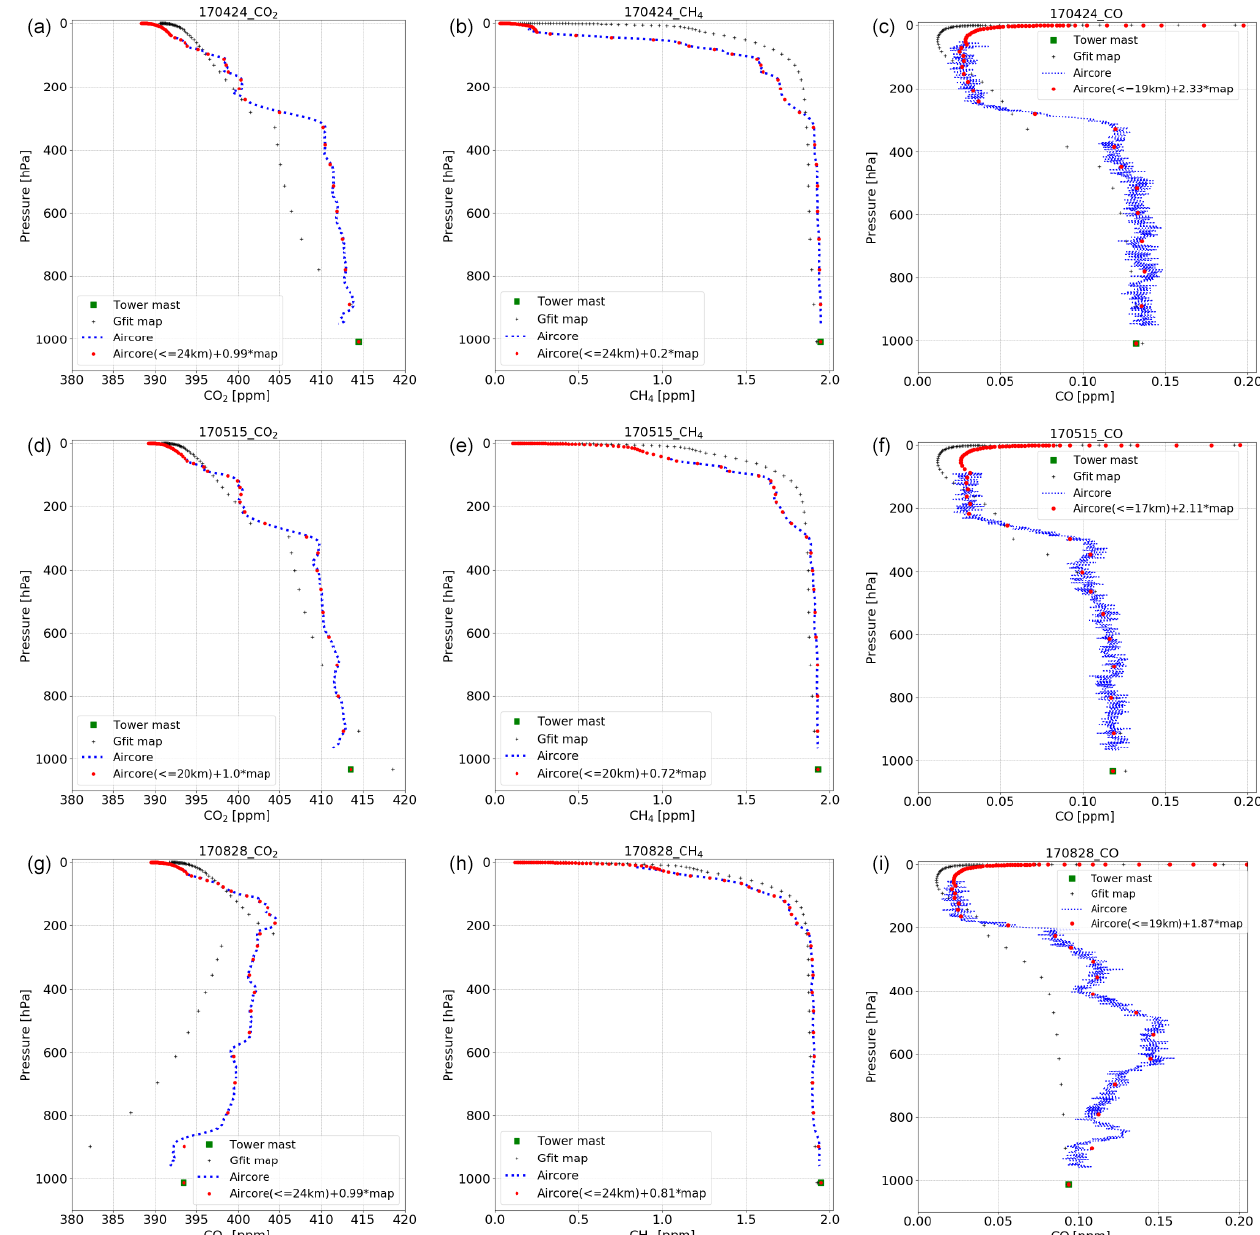
Figure 2. AirCore profile, GFIT map profile, AirCore extended profile, and tower mast measurements are plotted for XCO 2 (a, d, g) , XCH 4 (b, e, h) , and XCO (c, f, i) as a function of altitude for the following: 24 April 2017 with launch time at 15:13:39UTC and landing time at 16:13:10UTC (a–c) ; 15 May 2017 with launch time at 09:33:22UTC and landing time at 10:25:32UTC (d–f) ; and 28 August 2017 with launch time at 09:13:15UTC and landing time at 10:10:33UTC (g–i)